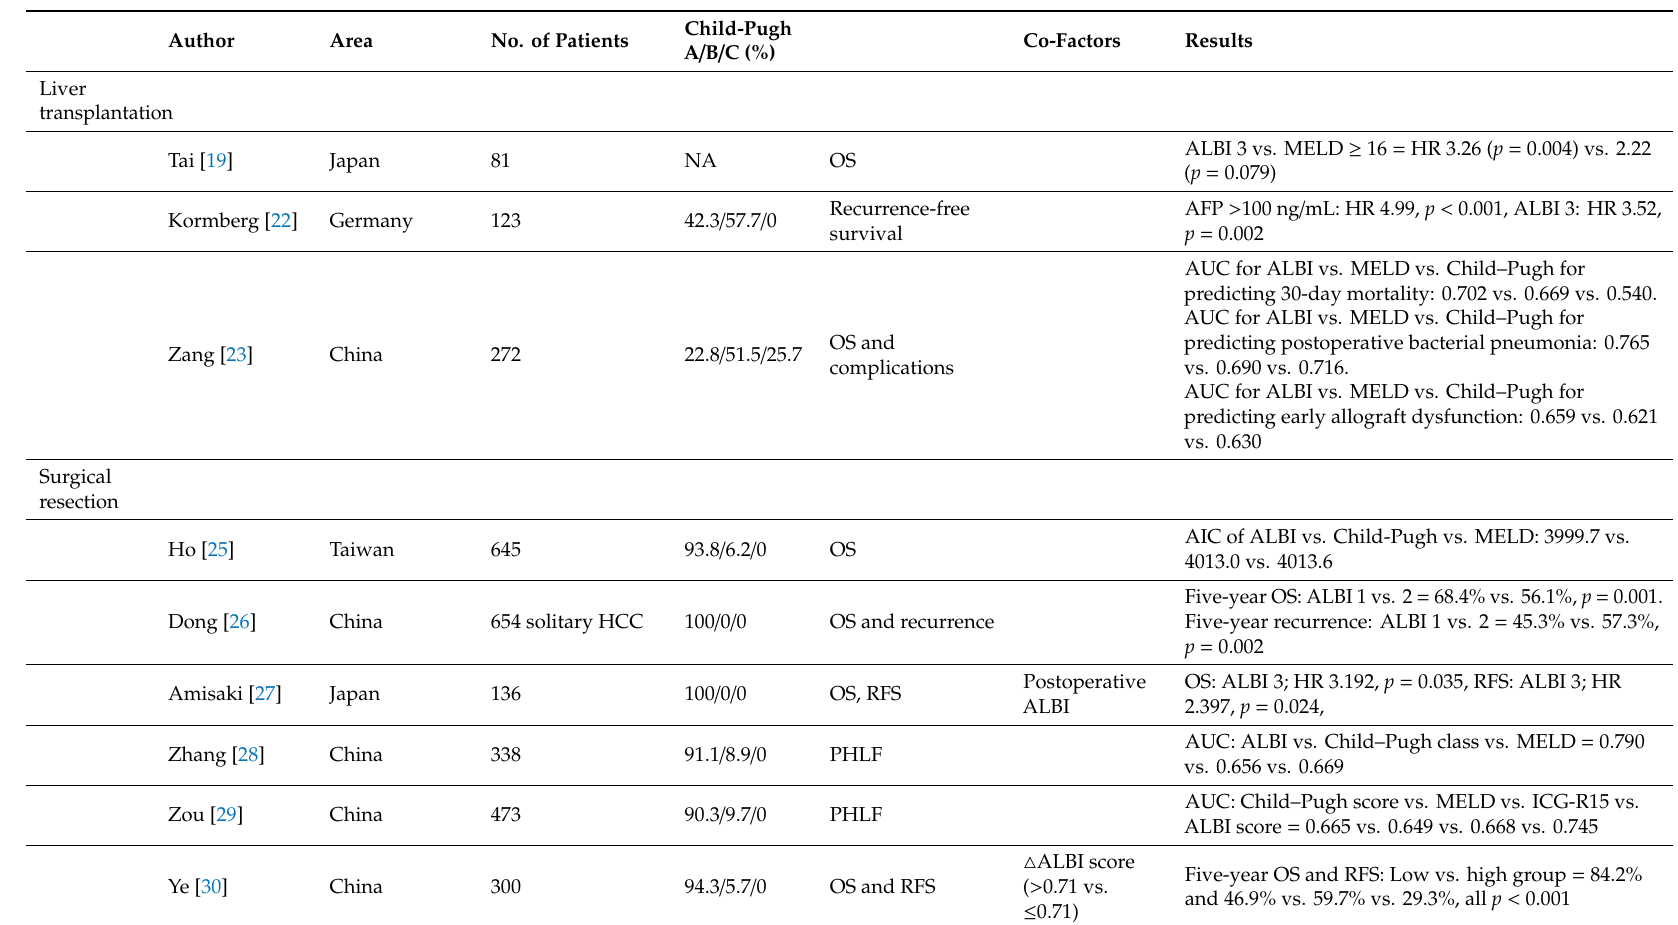
Table 2. Overall survival in association with the ALBI grade for each therapeutic